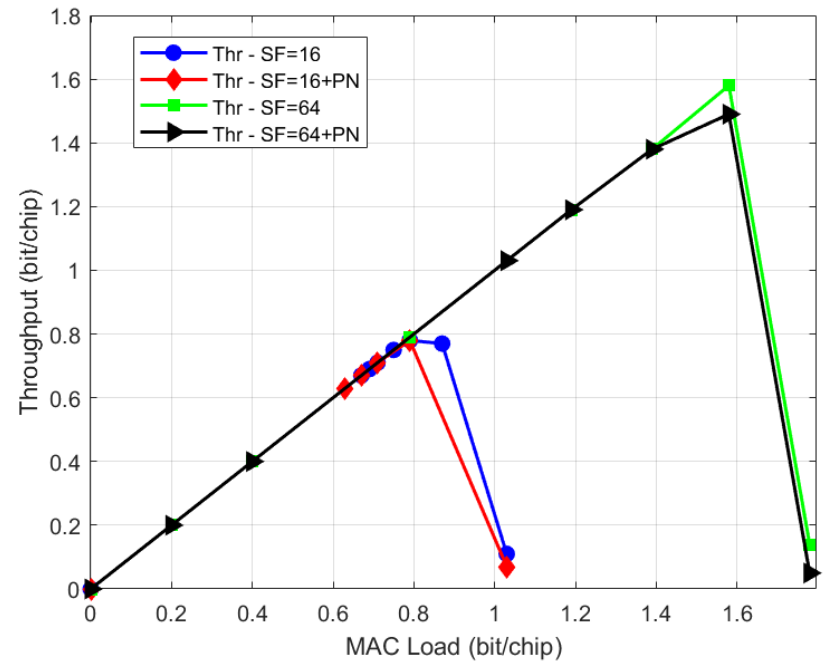
Figure 4. UC#1: F-SIM throughput performance.